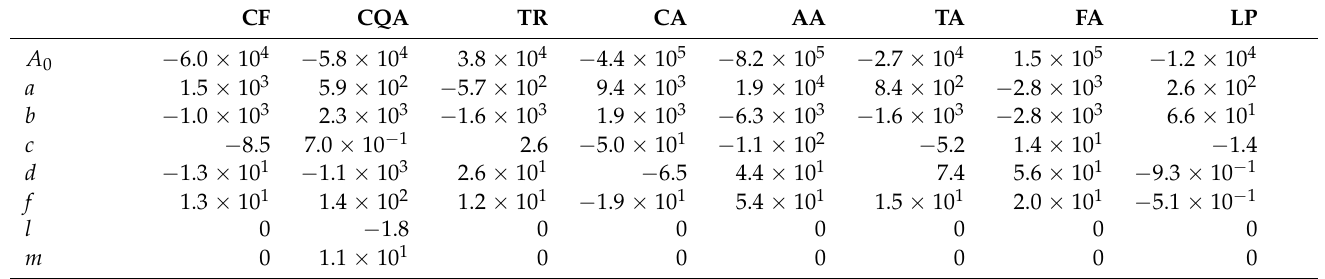
, k = CF, CQA, TR, CA, AA, TA, FA, LP, for the k